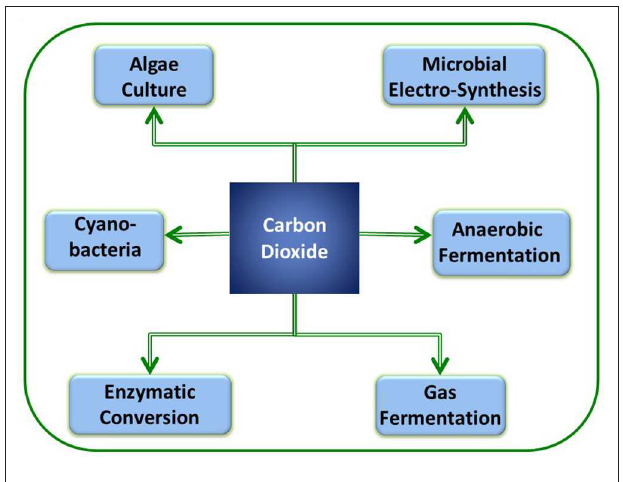
FIGURE 2 | Various biological processes that have potential for CO 2 sequestration along with sustainable bioenergy/chemical